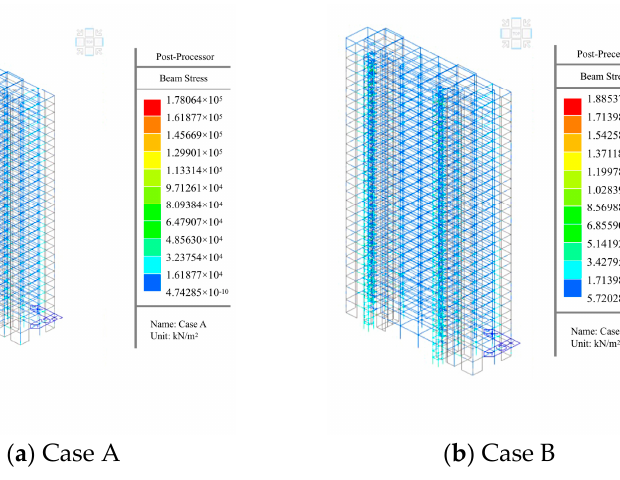
Figure 8. Structural stress cloud charts under the action of rare earthquakes. Table 5. Cost of steel for the post-installed